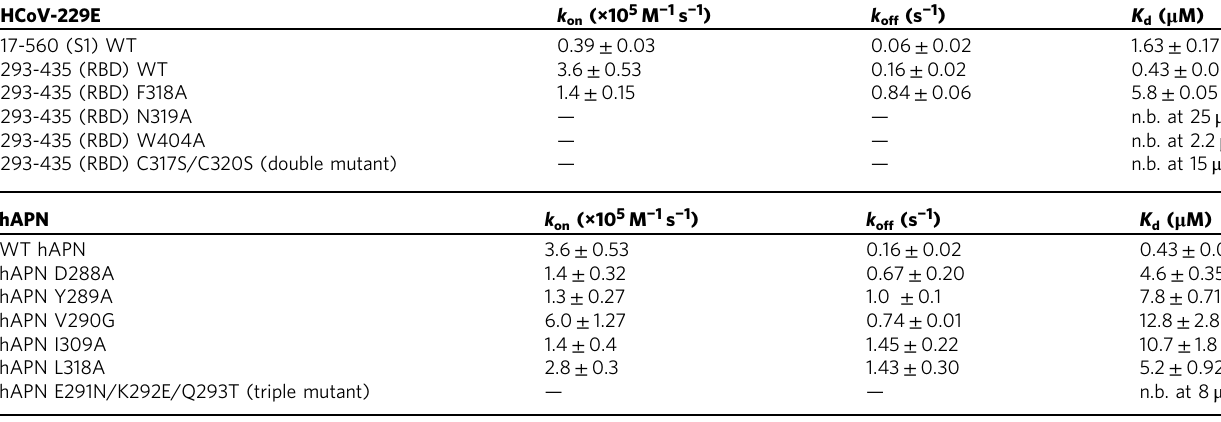
Table 1 Analysis of the hAPN ectodomain (residues 66 – 967, WT and mutants) interaction with fragments of the HCoV-229E S- protein (WT and mutants) using surface plasmon resonance